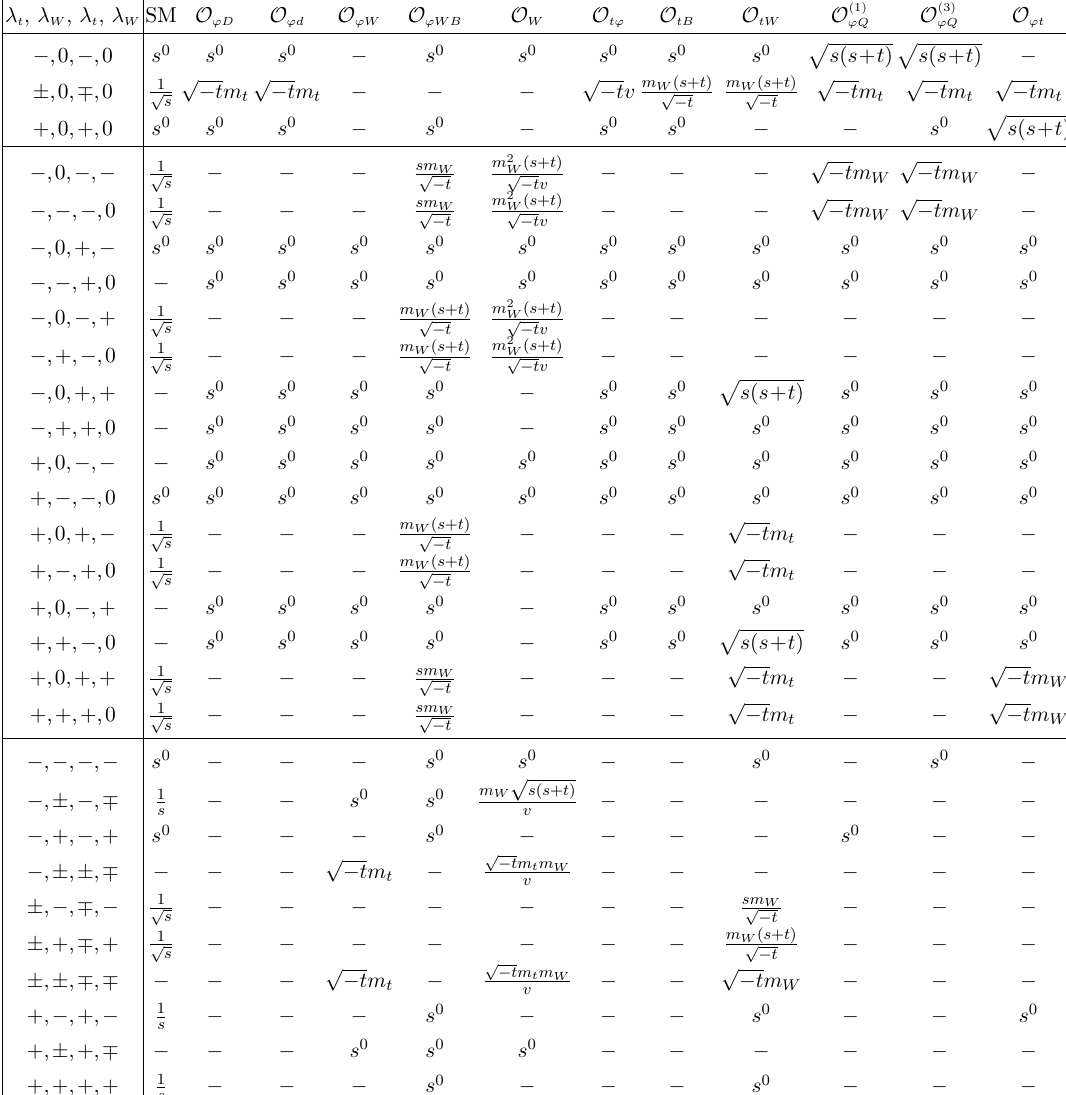
Table 13. Helicity amplitudes in the high-energy limit ( s Overall multiplicative factors are dropped and only the schematic energy dependence is retained for the SM contribution. Helicity entries marked by ‘ section 5.1.1 for a discussion of the